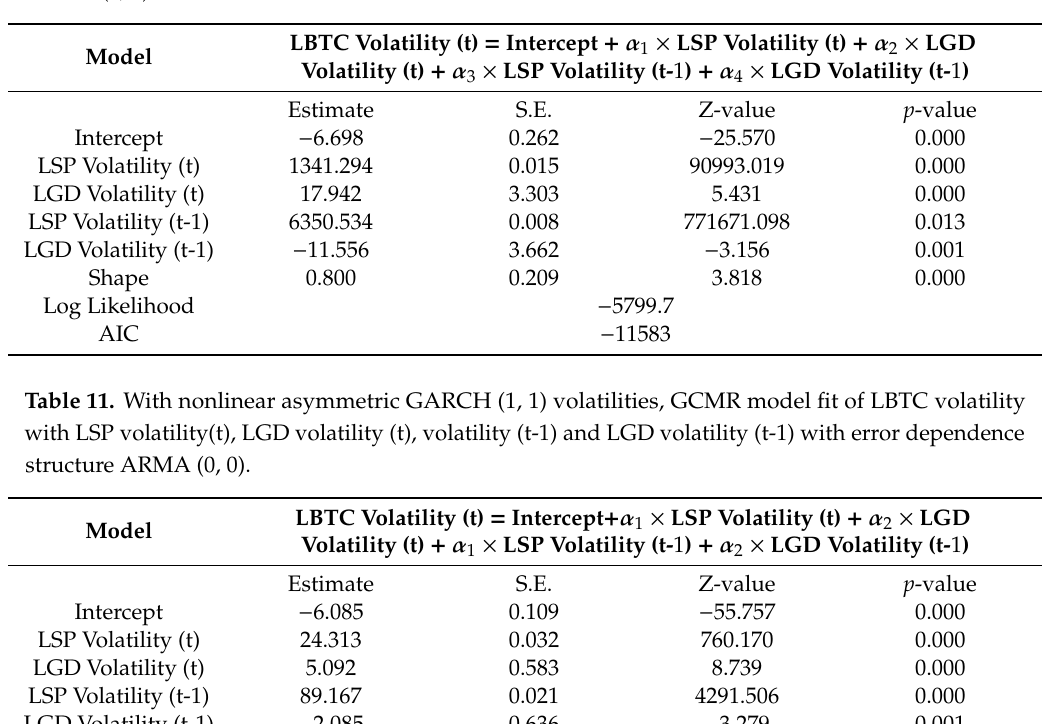
Table 10. With standard-GARCH (1, 1) volatilities, GCMR model fit of LBTC volatility with LSP volatility(t), LGD volatility (t), volatility (t-1) and LGD volatility (t-1) with error dependence structure ARMA (0, 0).